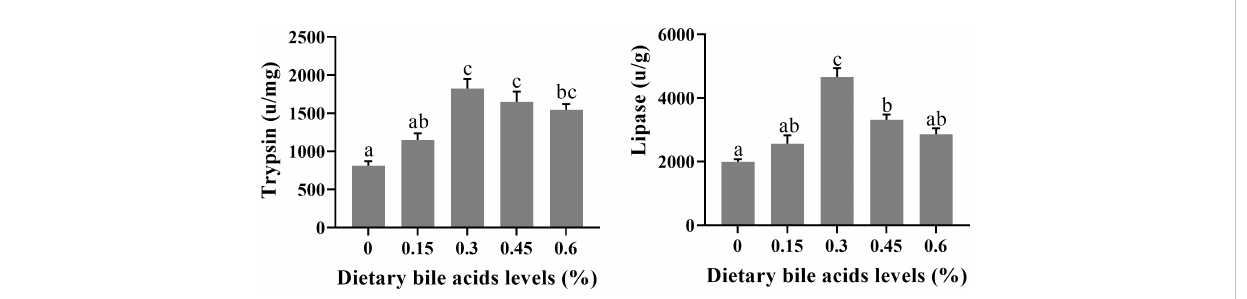
FIGURE 1 Effects of dietary bile acids levels on intestine digestive enzyme activities of coral trout. Values are expressed as mean ± S.E.M (n=6). Different letters indicate signi fi cant differences among groups ( P < 0.05).